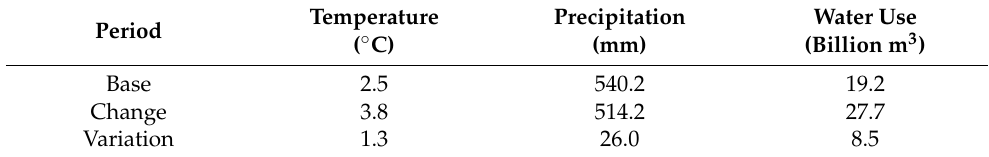
Table 3. Changes in each impact factor.